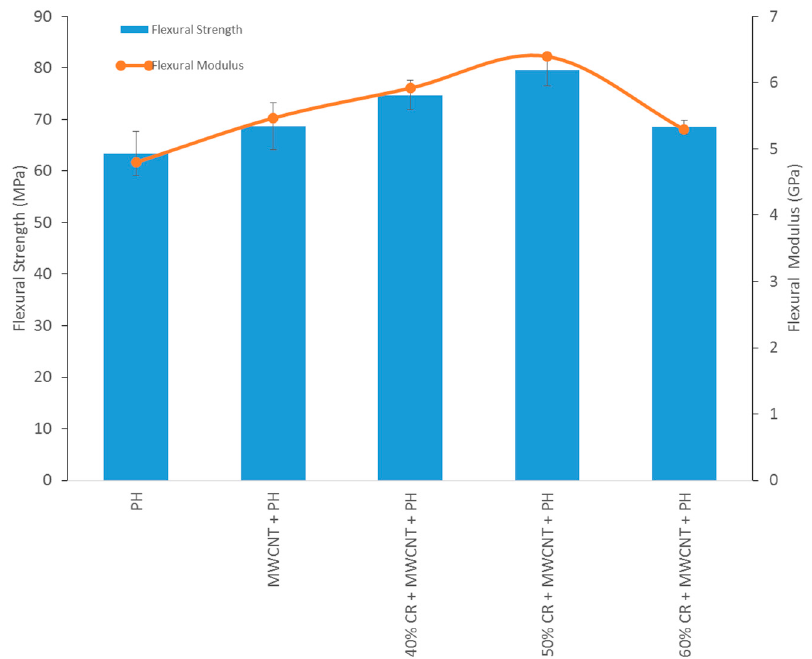
Figure 9. Effect of CR fiber loading on flexural strength and Modulus of MWCNT-Phenolic compo- sites.